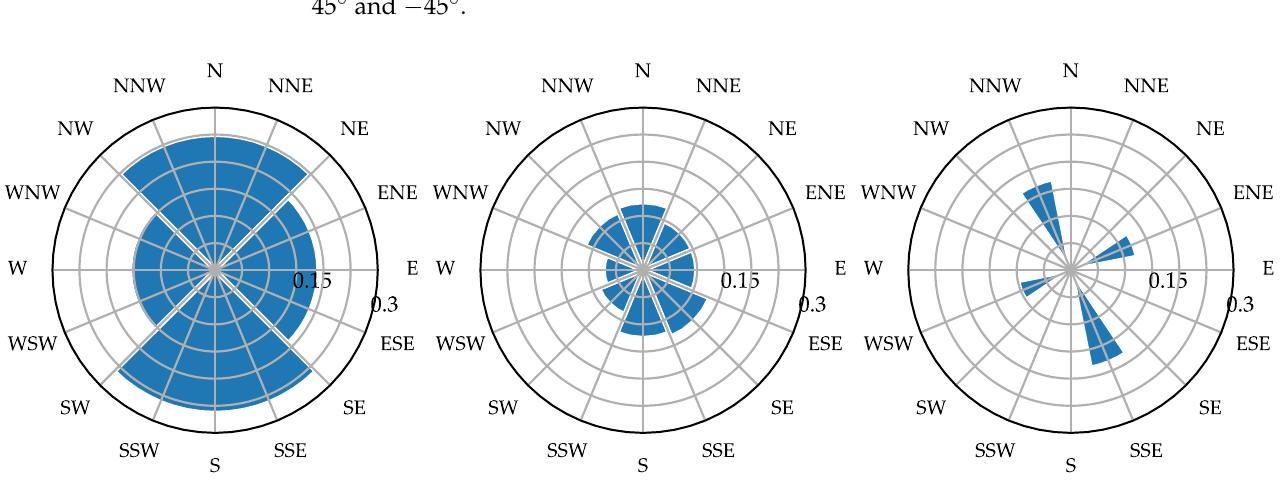
Figure 3. Class distribution of the roof segment labels by relative area for three dataset configurations—4, 8, and 16 azimuth classes, from left to right. Acronyms mean south (S), south–east (SE), south–south-west (SSW), etc.